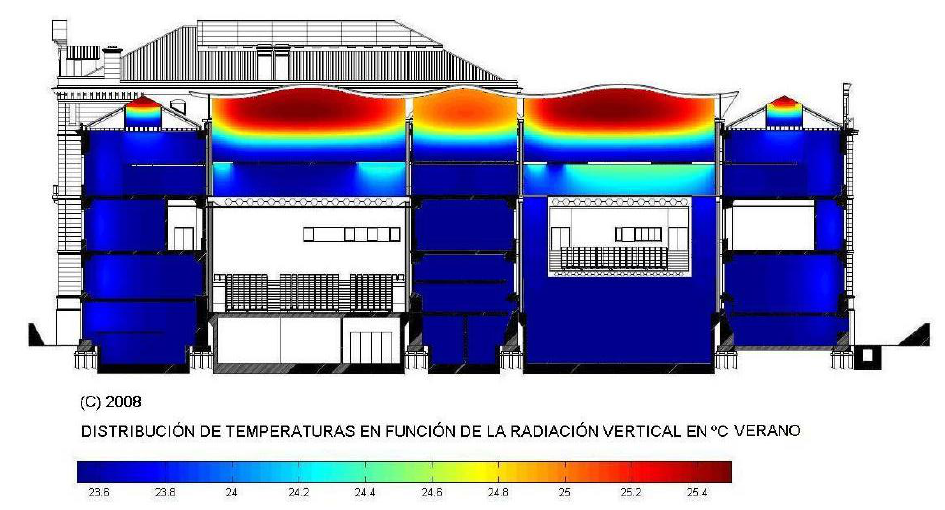
Figure 17. Vertical distribution of temperatures in deg. C, during summer.